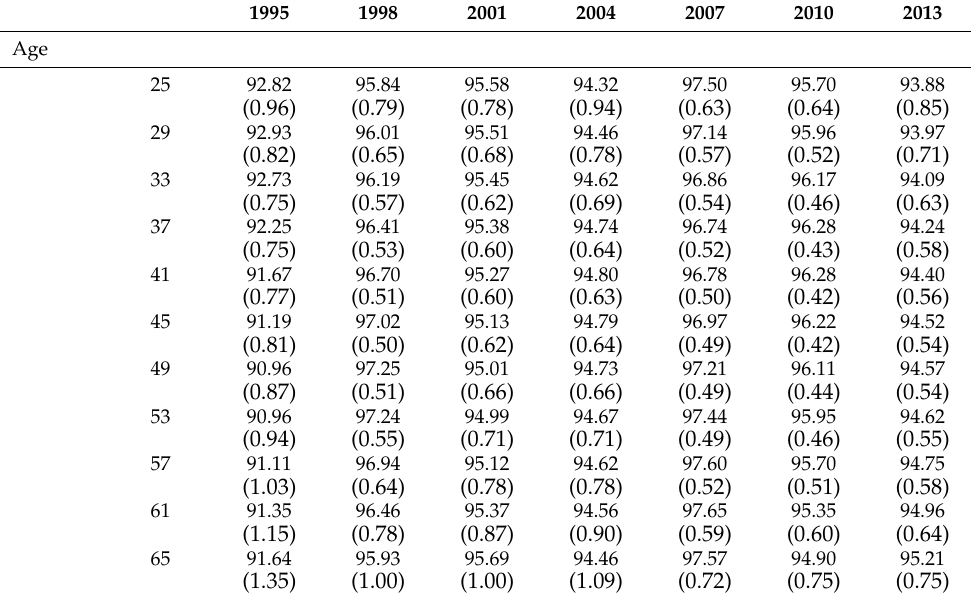
Table A6. Estimates of Applicants for Credit for